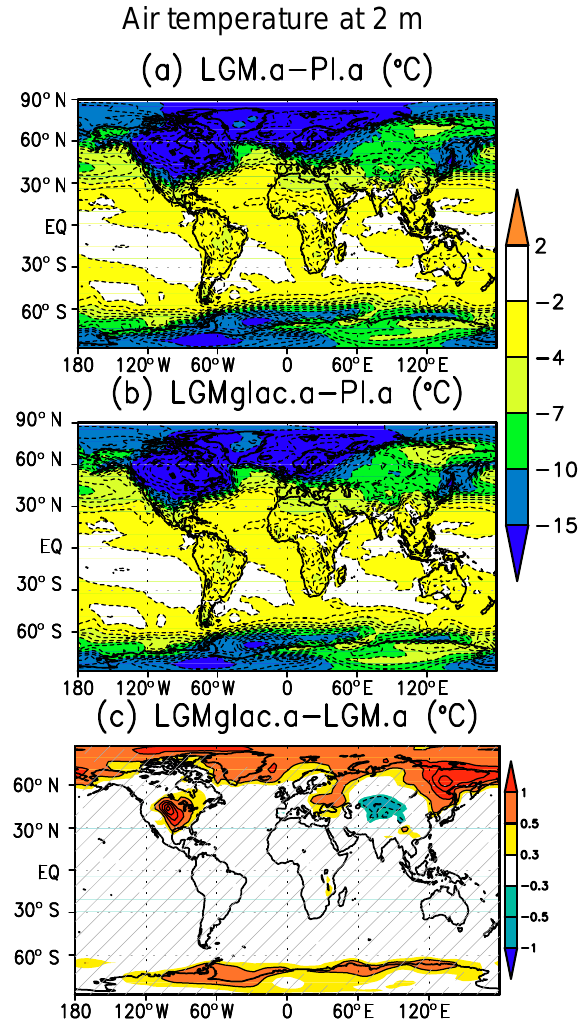
Figure 6. Difference in surface temperature at 2m of height ( ◦ C) for (a) LGM.a–PI.a, (b) LGMglac.a–PI.a, and (c) LGMglac.a– LGM.a. Change is considered not significant at the 95% confidence level in the hatched area based on a t